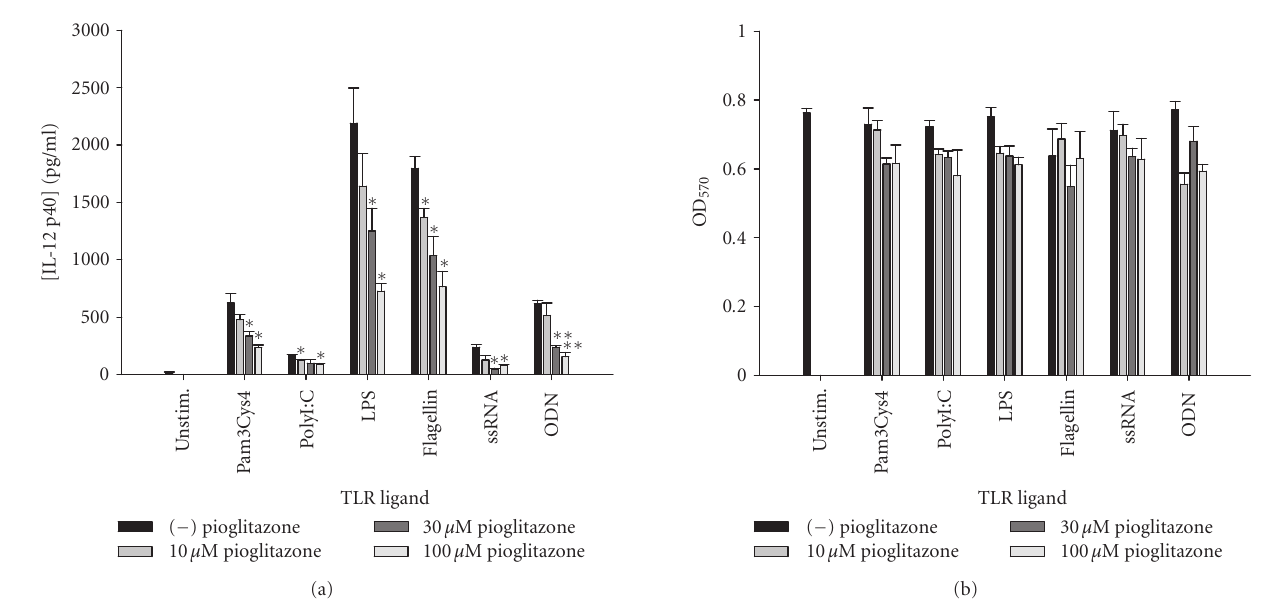
Figure 11: The TZD pioglitazone inhibits astrocytic IL-12 p40 expression in response to diverse TLR ligands. Primary astrocytes were plated at 1 × 10 5 cells/well in 96-well plates and incubated overnight. The following day, cells were pretreated for 1hour with the indicated concentrations of pioglitazone prior to the addition of TLR ligands. Cell-conditioned supernatants were collected at 24 hours following TLR ligand exposure, whereupon IL-12 p40 levels were determined by ELISA (a). The e ff ects of pioglitazone on astrocyte viability were assessed using an MTT assay (b). Significant di ff erences between astrocytes treated with TLR ligands alone versus TLR ligands + pioglitazone are noted with asterisks ( ∗ P < . 05; ∗∗ P < . 001). Results presented are representative of two independent experiments.